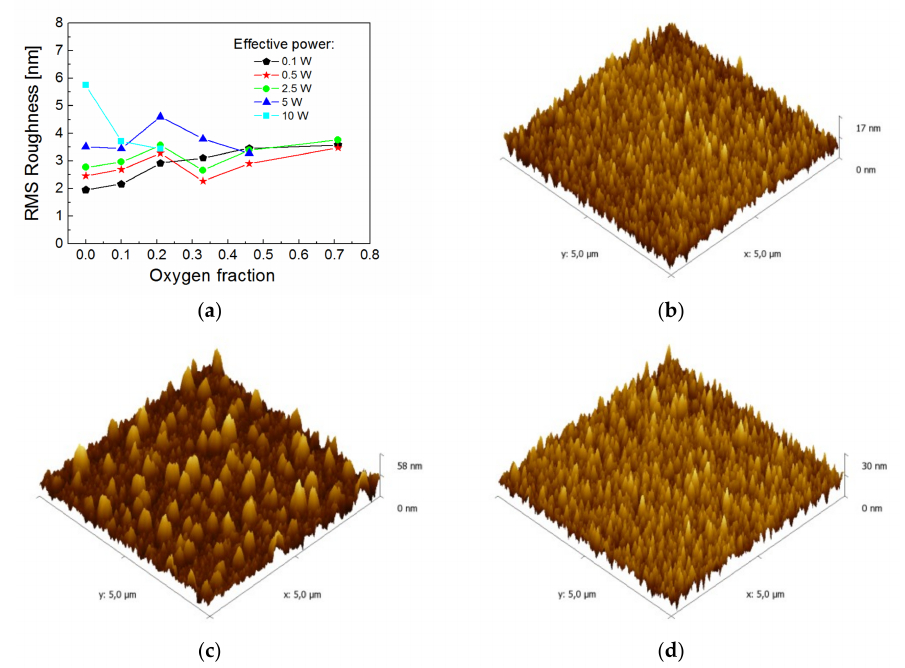
Figure 4. Surface topography of thin films: ( a ) RMS roughness dependent on the oxygen fraction for different effective power, ( b ) AFM image (zero oxygen fraction, 0.1 W), ( c ) AFM image (zero oxygen fraction, 10 W), ( d ) AFM image (0.71 oxygen fraction, 0.1